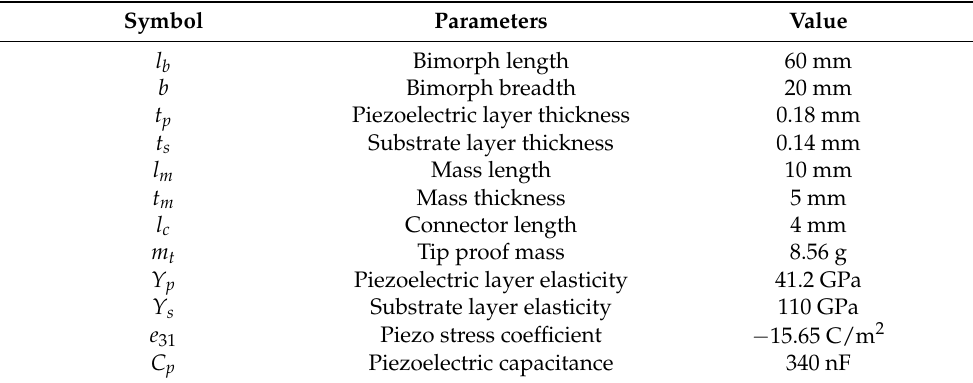
Figure 1. Schematic of PVEHs: ( a ) L-shaped PVEH and ( b ) U-shaped PVEH. Table 1. Design and simulation parameters of PVEHs.